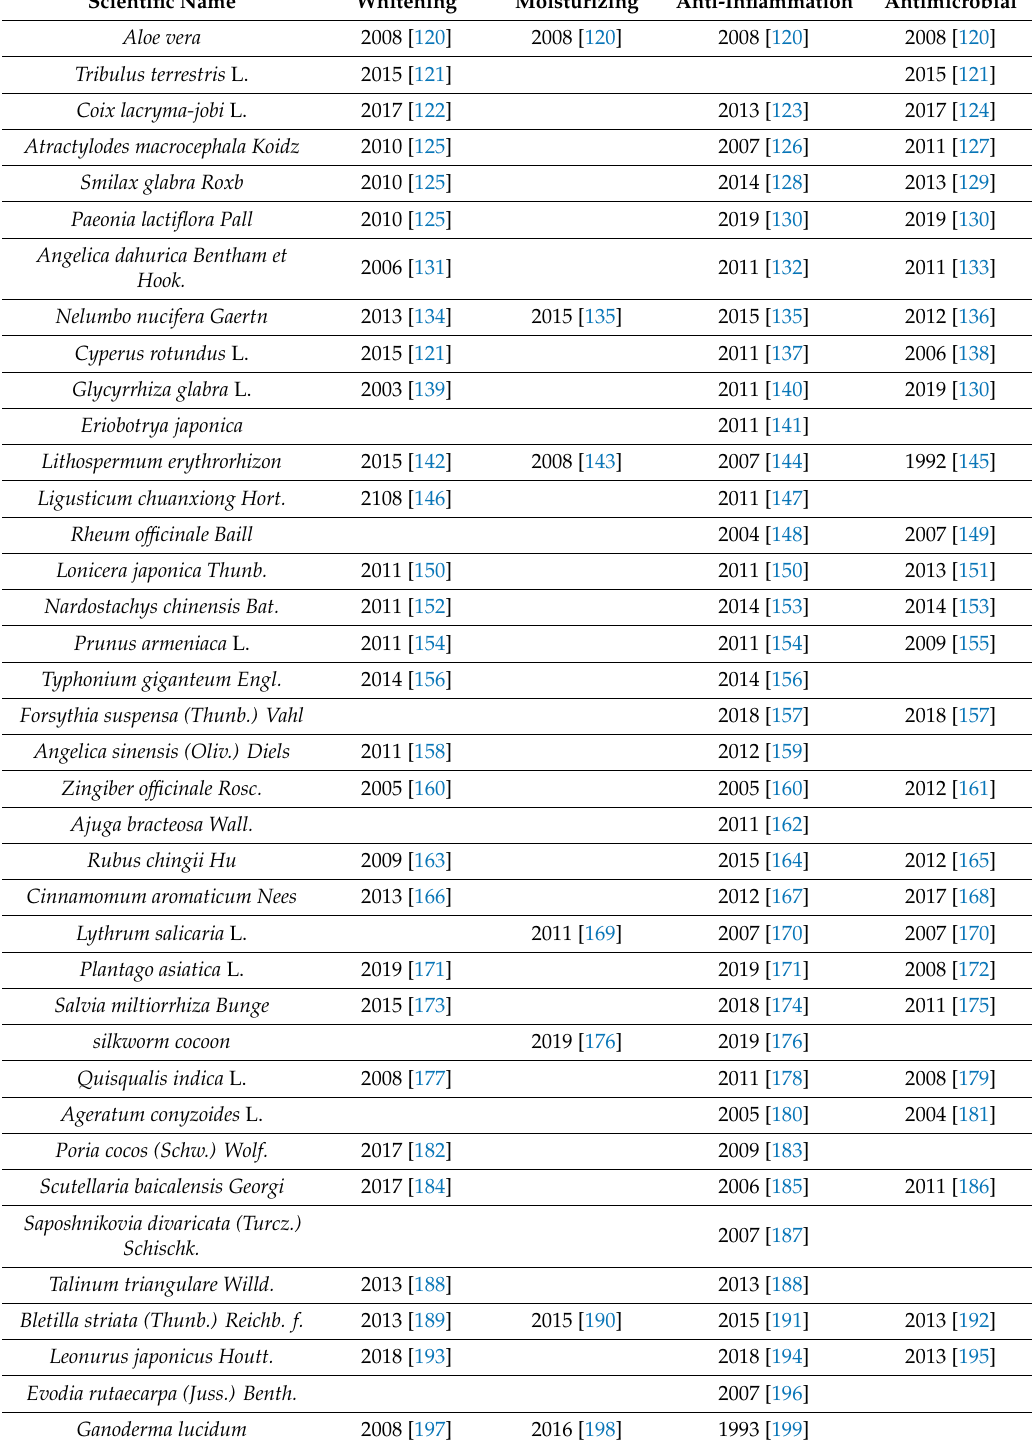
Table 3. Natural products applied in